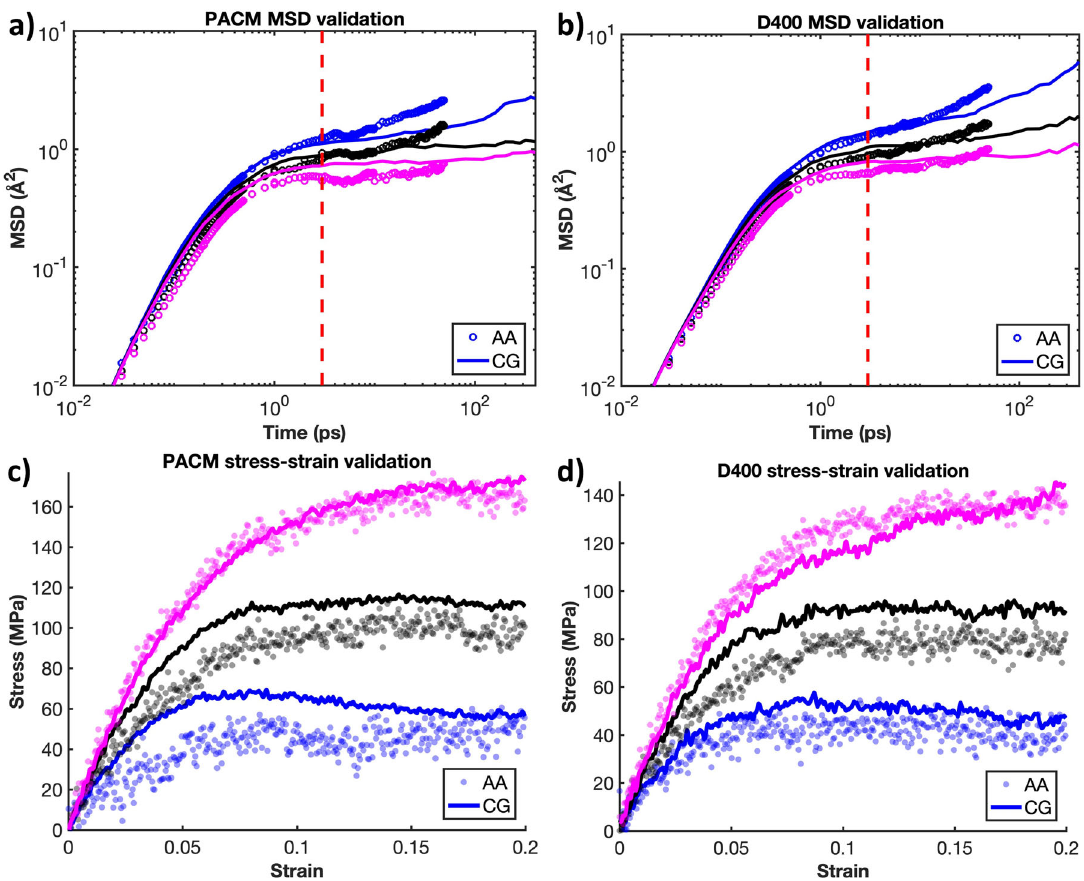
Fig. 6 CG validation of the ML parametrization. For our DGEBA + PACM and DGEBA + D400 systems the CG parameters chosen for the non- bonded interactions not only match the target properties we selected (as shown in Fig. 5) but can also predict the whole MSD ( a , b ) and tensile stress curves ( c , d ), validating our choice of targets as good predictors of the systems dynamics and mechanical